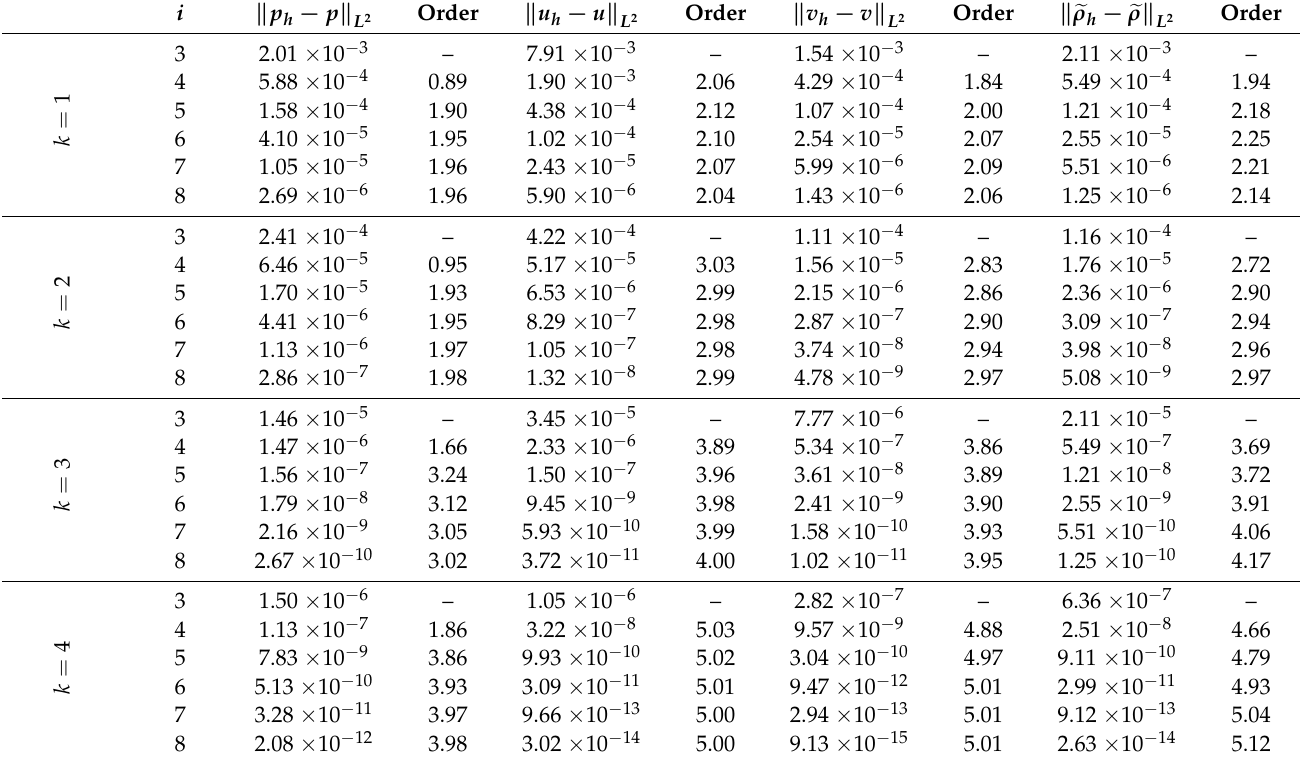
Table 1. Kovasznay test case—Pressure ( p ), velocity components ( u , v ), and working density ( (cid:101) ρ ) errors computed in L 2 -norm with the respective order of convergence for the DG space discretization of the polynomial degree k = { 1,2,3,4 } on grids of 2 2 i square